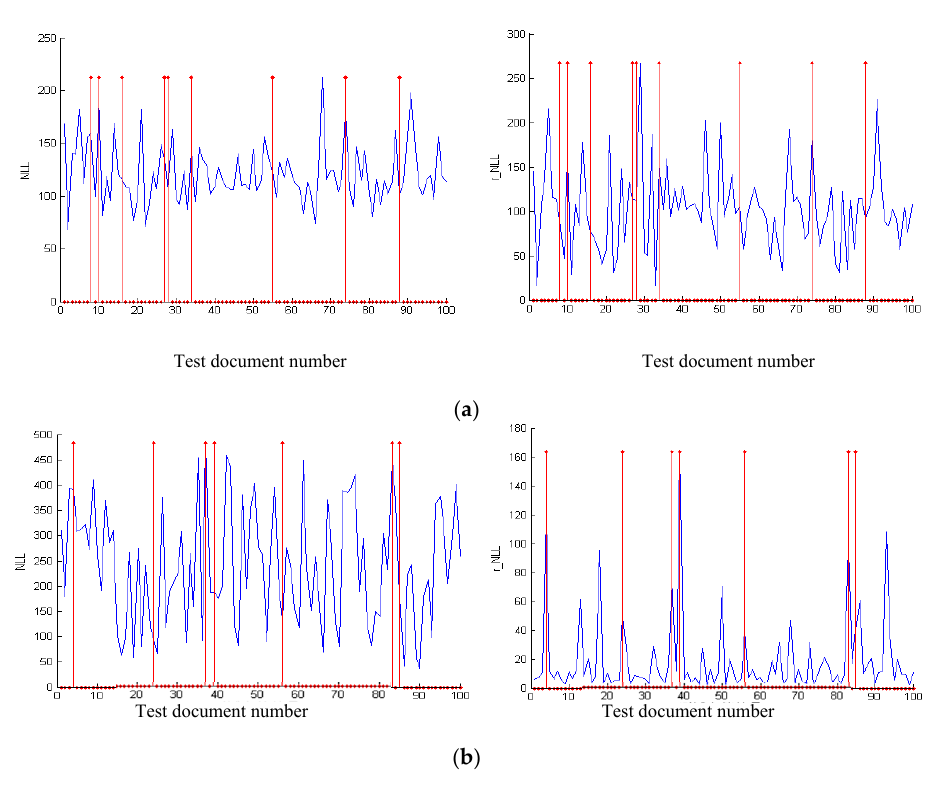
Figure 6. The NLL and r_NLL comparisons of our model and actual values. ( a ) NLL (left and blue) and r_NLL (right and blue) comparisons of RTM-HSVG. ( b ) NLL (left and blue) and r_NLL (right and blue) comparisons of RTM-GS.